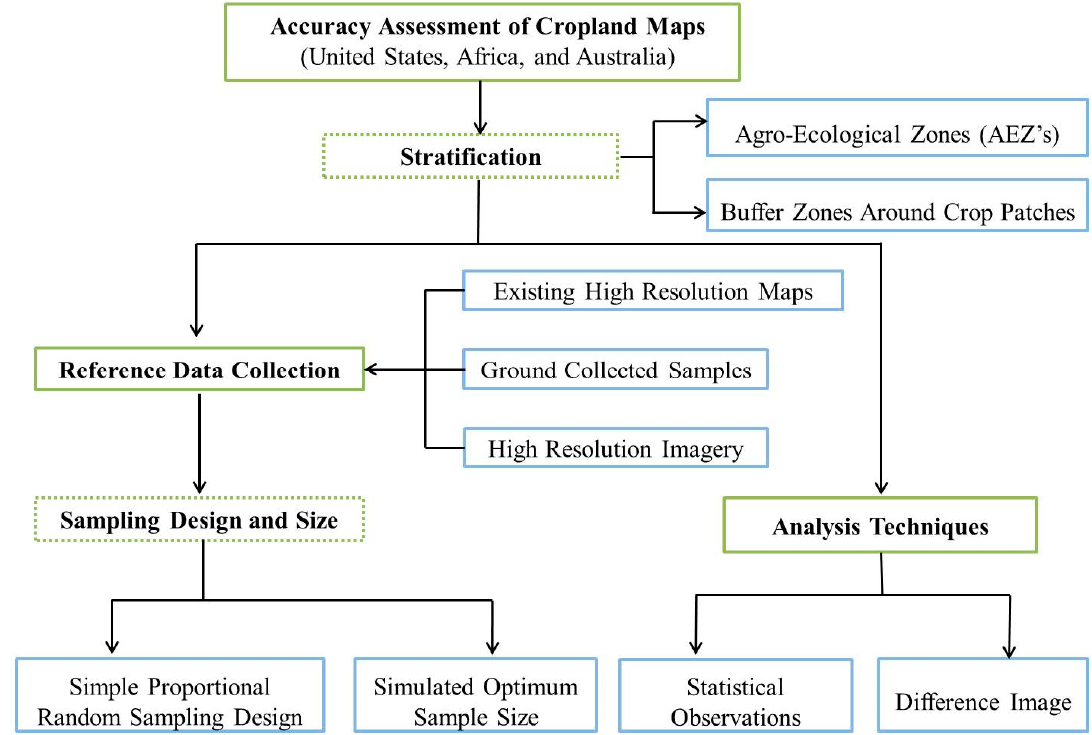
Figure 2. Flowchart of the process used to conduct the continent-based accuracy assessment of the GFSAD mapping products.